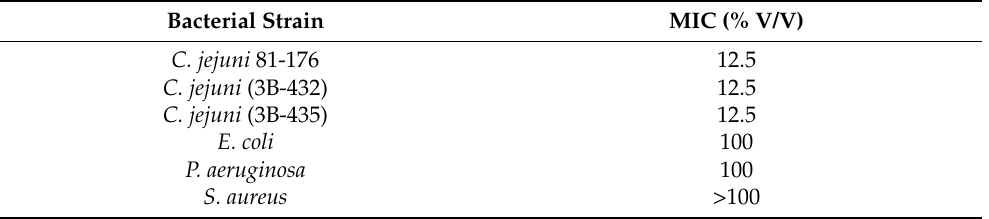
Table 2. Minimal inhibitory concentrations (MICs) of H. italicum